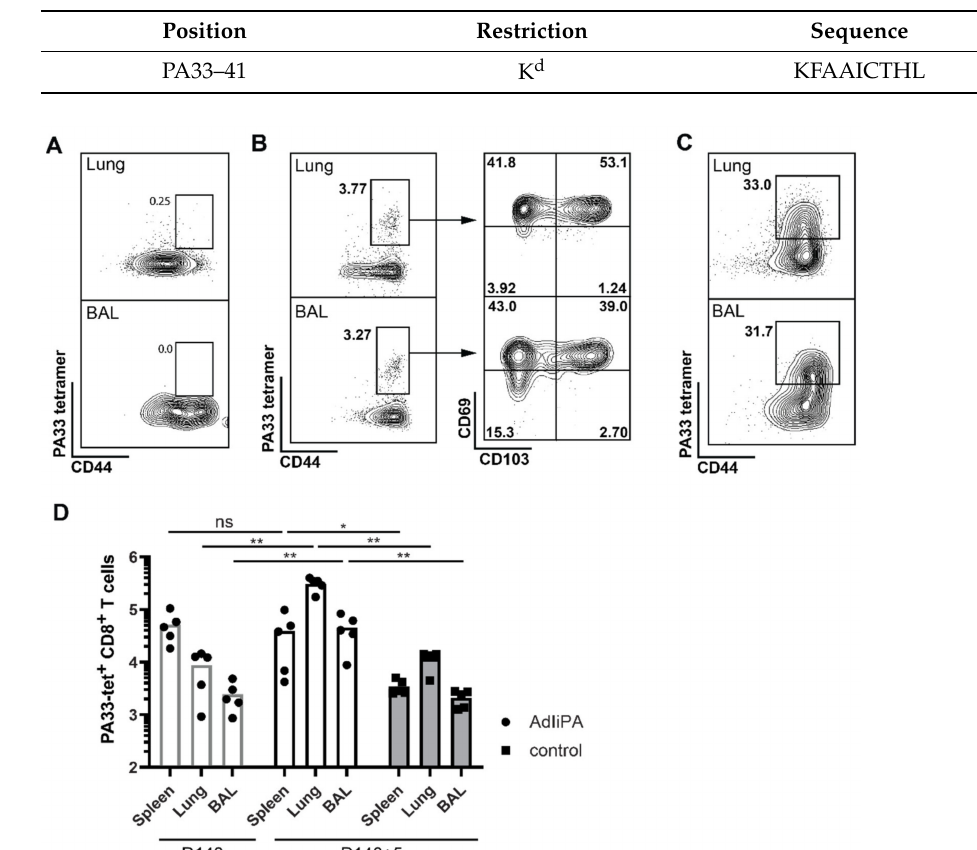
(Table 1, Figure 3D). CD8 T cells producing IFN γ after stimulation with PA33 peptide were found in all tissues analyzed: spleen, MLN, and BAL. Using the newly identified epitope, we also confirmed the PA33 specificity using a tetramer (Figure 4A,B). As previously described, we did not observe an expansion of the localized PA population in the challenged AdIiPA-vaccinated C57BL/6 mice, which could in part explain why we did not have optimal protection in these mice. To investigate if there was an expansion of the PA33- specific cells after challenge in BALB/c mice, we enumerated the number of PA33-specific CD8 T cells in BALB/c mice at resting memory phase and after challenge (Figure 4B–D). In contrast to what we observed in C57BL/6 mice, the PA33 population expanded more than 10-fold in both lungs and BAL following intranasal challenge (Figure 4D). Analyzing the expression of residency markers of the PA-specific memory CD8 T cells, a majority of these expressed CD69 and a large proportion also expressed CD103 (Figure 4B), illustrating that the cells induced by the immunization were resident memory T cells. Table 1. Novel H-2 d PA epitope.